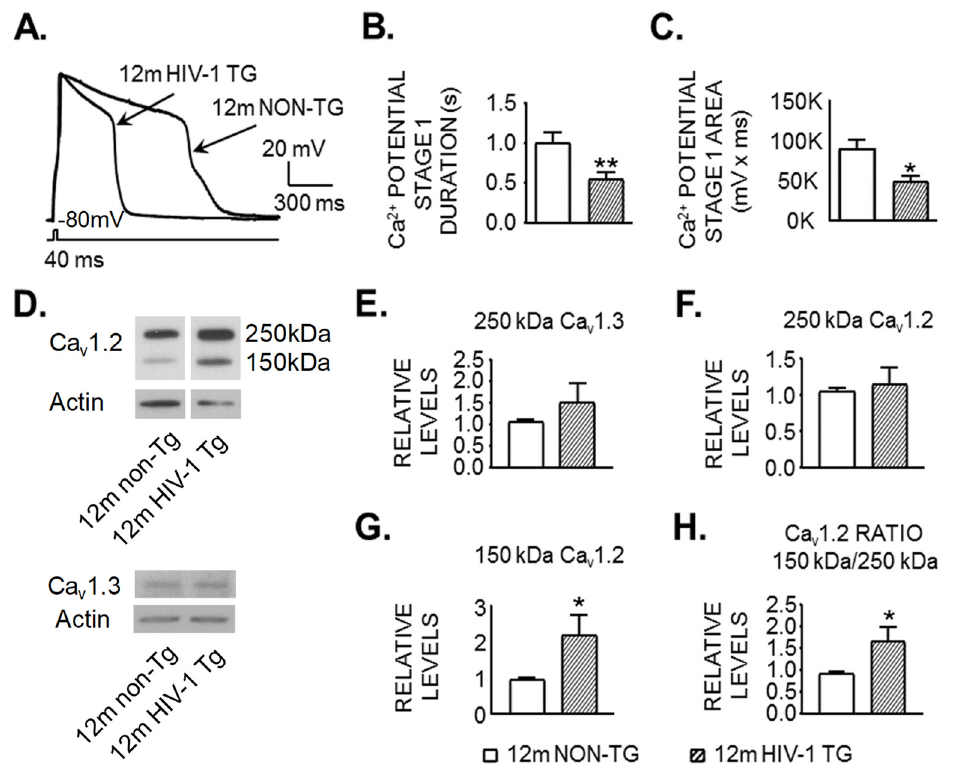
Figure 2. Reduced Ca 2+ influx via VGCCs is accompanied by increased expression of a shorter form, less functional Ca v 1.2 L-channel in the HIV-exposed dorsal striatum of 12mo rats. ( A ) Representative traces showing evoked Ca 2+ spikes in striatal MSNs from a 12mo-old non-Tg and HIV-1 Tg rat. ( B , C ) The Ca 2+ spike duration ( B ) and area ( C ), which reflect Ca 2+ influx through VGCCs, are graphed. Note that striatal neurons from HIV-1 Tg rats (hatched bars, n = 8 in 4 rats) had significantly reduced Ca 2+ influx compared to those from non-Tg rats (open bars, n = 12 in 10 rats). ( D – H ) L-channel protein levels were measured in the caudate-putamen dissected from 12mo-old HIV-1 Tg (n = 7–8) and non-Tg rats (n = 7). ( D ) Representative western blots. For the representative Ca v 1.2 bands, the samples were run on the same gel, but were inverted compared with the order shown; i.e., the bands were rearranged to achieve the desired order for presentation. Supplementary Figure S1 shows the full blots for the representative samples. ( E – H ) Bar graphs showing relative levels of L-channel protein normalized to β -actin protein for the full length LVA-Ca v 1.3 ( E ), the full-length (~250 kDa) HVA-Ca v 1.2 ( F ), the shorter, 150 kDa form of Ca v 1.2 (G), and the Ca v 1.2 ratio, 150 kDa/250 kDa ( H ). Significance is denoted as *: p ≤ 0.05, **: p ≤ 0.01; K =